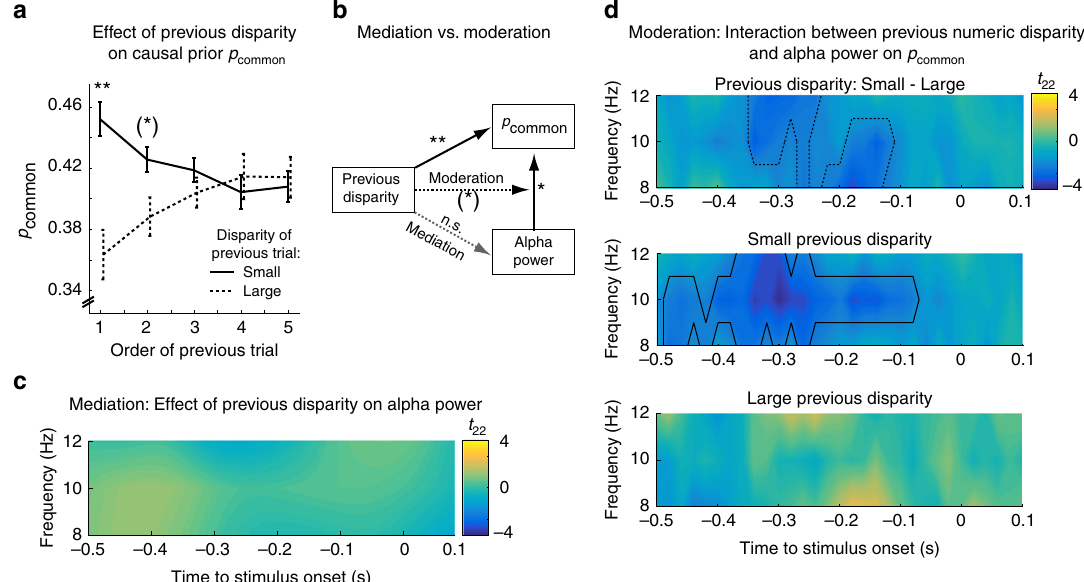
Fig. 7 The effect of prior numeric disparity on the BCI model ’ s causal prior ( p common ) and prestimulus alpha power. a Effect of previous numeric disparity on causal prior p common (across-participants ’ mean ± within-participants ’ SEM, n = 23) as a function of the numeric disparity (small: ≤ 1 vs. large: ≥ 2) of the previous trial of order 1 – 5. The effect of previous numeric disparity on causal prior decays with increasing trial order. Asterisks denote statistical signi fi cance in two-sided one-sample t 22 tests (**: p < 0.01, *: p < 0.05, (*): p < 0.1, n.s.: not signi fi cant). b Mediation and moderation: Previous numeric disparity and pre-stimulus alpha power signi fi cantly predict p common . However, previous numeric disparity does not predict pre-stimulus alpha power. Hence, pre-stimulus alpha power does not mediate the effect of numeric disparity on the causal prior. Instead, we observed a marginally signi fi cant interaction between previous numeric disparity and alpha power suggesting that previous numeric disparity moderates the effect of pre-stimulus alpha power on p common . c Mediation: Effect of previous numeric disparity on alpha power: Time-frequency t -value map ( n = 23, averaged over occipital electrodes) reveals no signi fi cant difference in prestimulus alpha power between small vs. large previous numeric disparity (i.e. trial order 1). All clusters